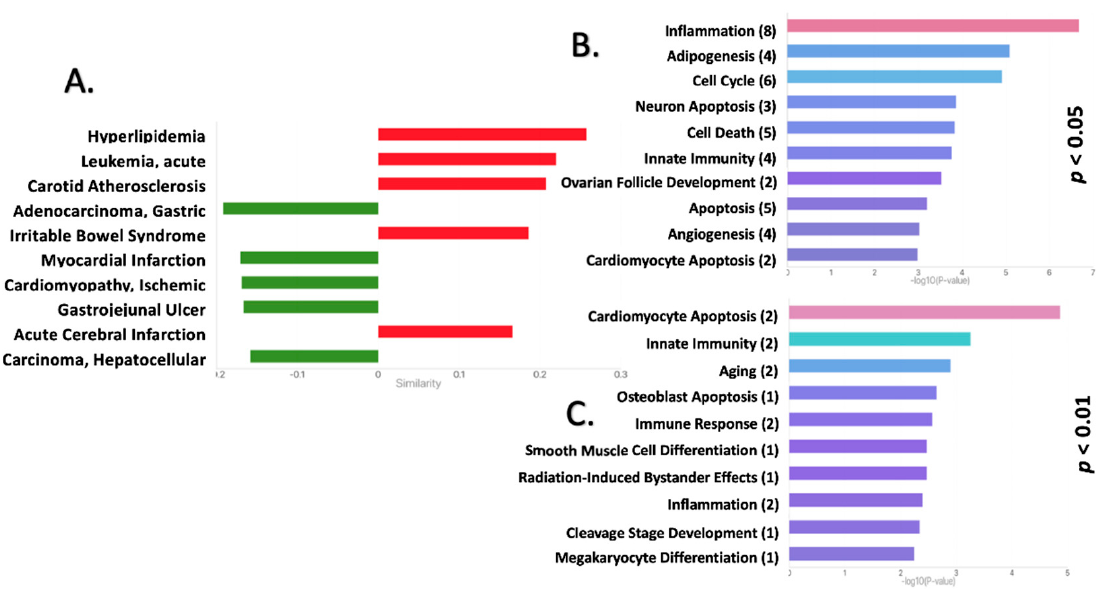
Figure 4. Functional pathways and disease correlations targeted by the DEmiRNAs in EAT: TAM 2.0 identified both disease pathologies ( A ) and functional pathways ( B ), associated with the miRNAs differentially expressed (all with p < 0.05) in EAT from patients with and without CAD as well as the functional pathways associated with the two miRNAs that had p < 0.01 ( C ); (functional association strength is expressed as the-log 10 ( p ) along the x -axis). Negative similarity scores in panel A (green) indicate that the regulation of the miRNAs was opposite to the normal regulation seen in the disease pathology while positive scores (red) indicated that the regulation of the miRNAs was the same direction as the regulation normally seen in the disease pathology. Coloration of the bars in panels ( B , C ) is for stylization and not meant to reflect particular values. Cardiac diseases and cardiomyocyte apoptosis had the highest correlations.